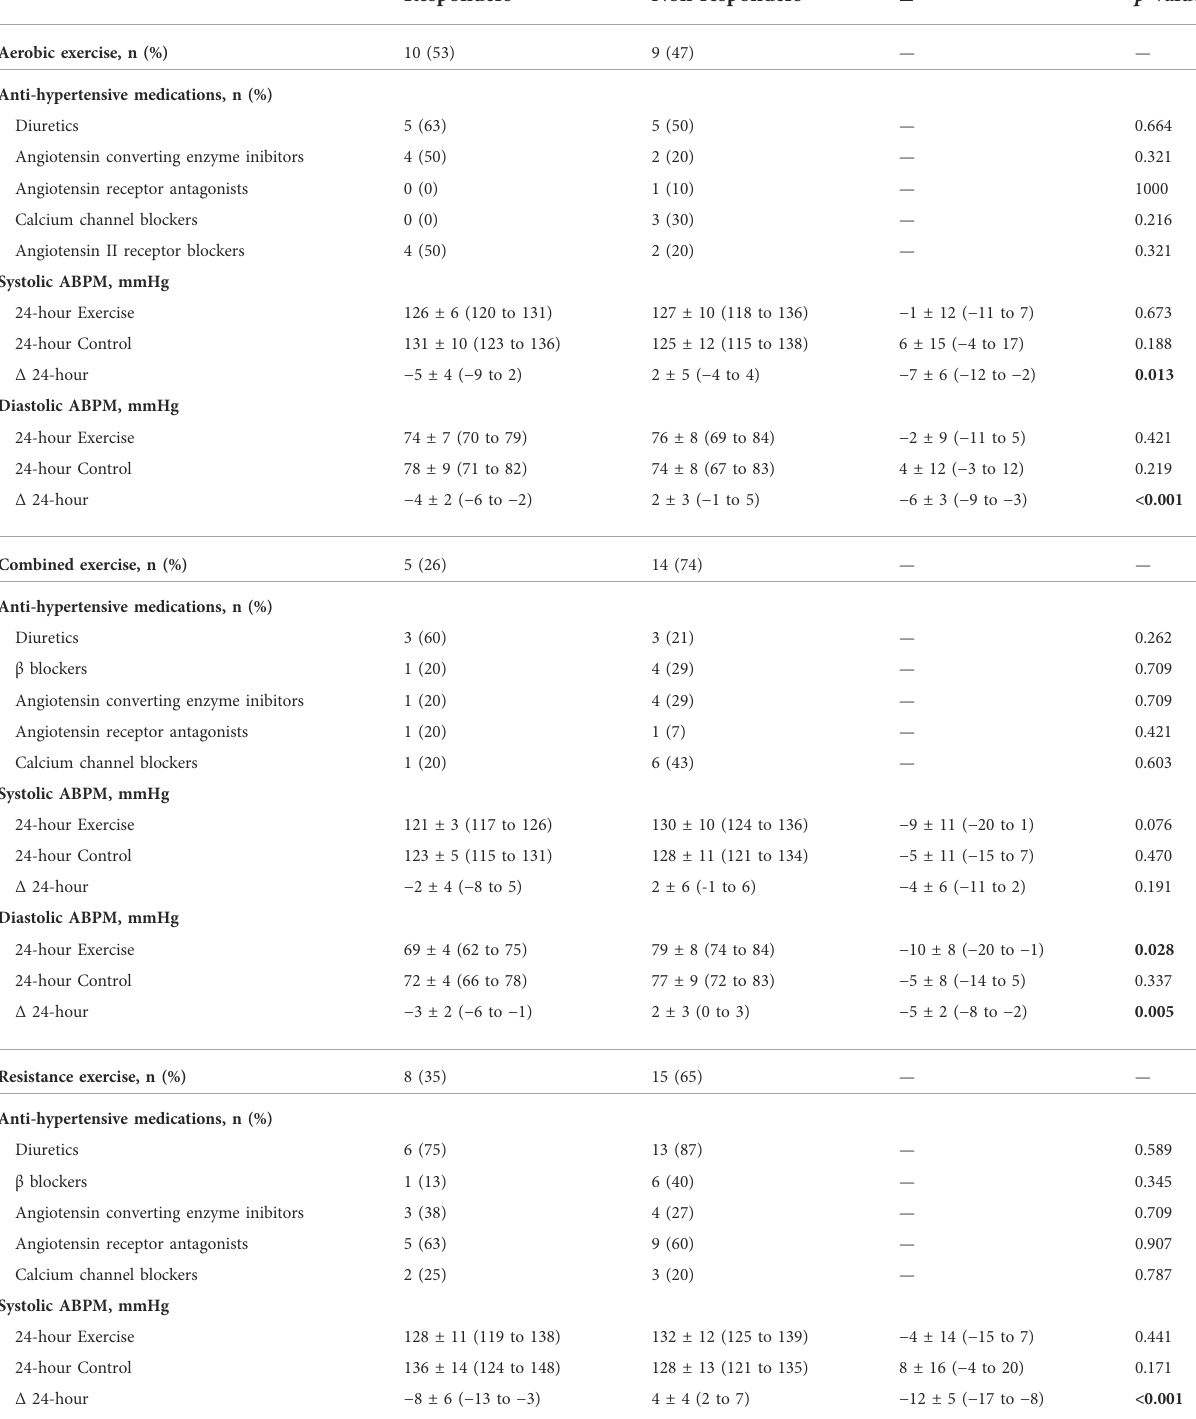
TABLE 4 Differences in characteristics between responders and non-responders for 24-h diastolic BP in each exercise modality. Responders